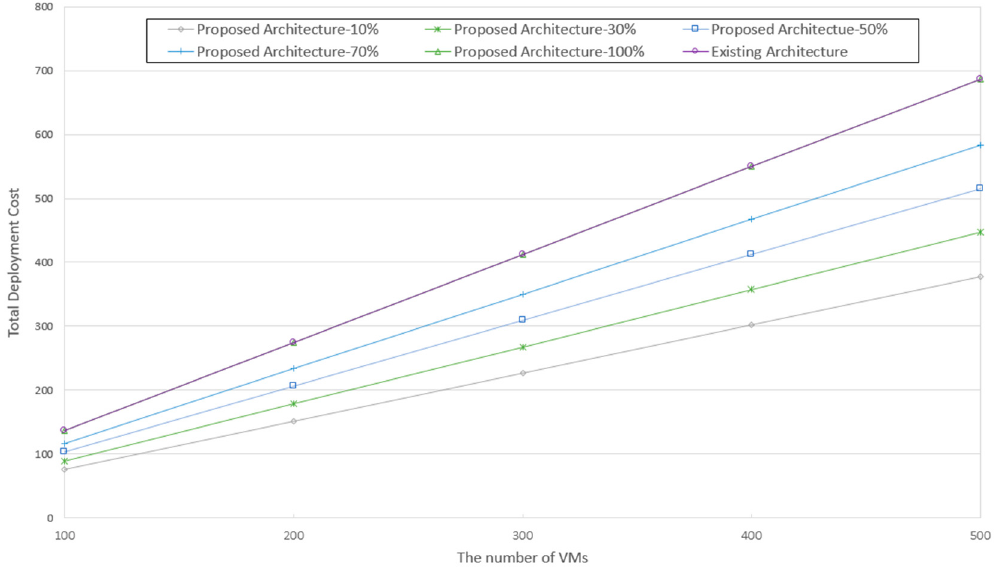
Figure 14. Multiple service fault monitoring performance .